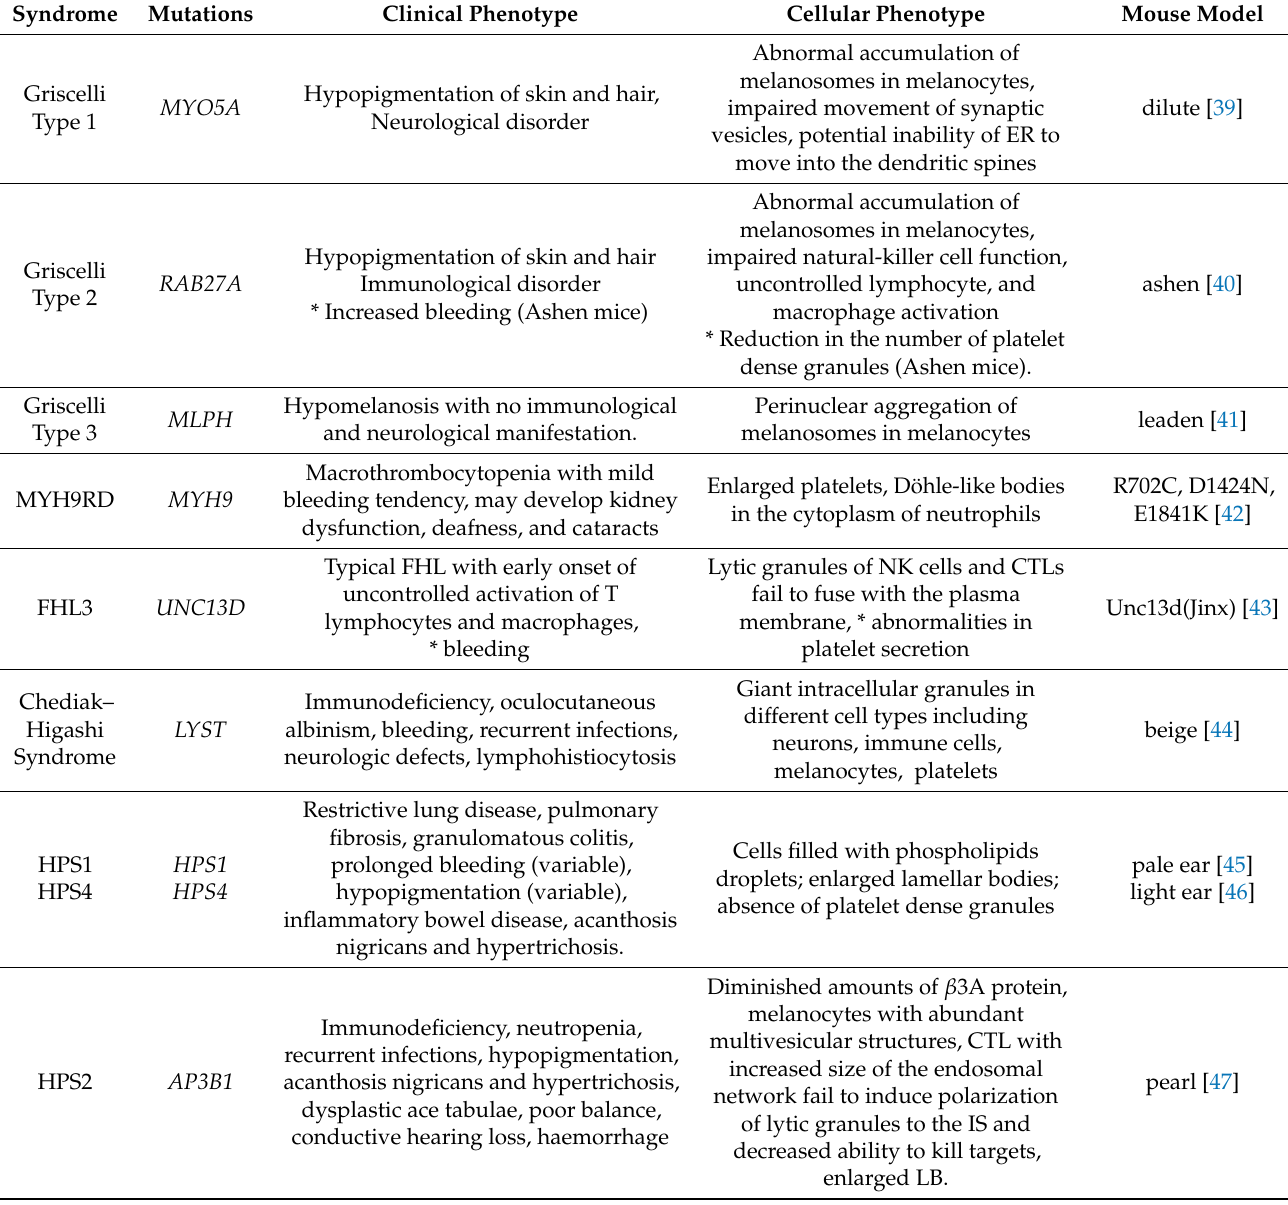
Table 1. Multisystem disorders associated with mutations in genes involved in vesicular trafficking to LROs. Mutated gene, clinical and cellular phenotype as well as the correspondent mouse model are reported. * Abnormalities observed in the mouse model. Abbreviations: MYH9 , Myosin-9; MYH9RD, MYH9-related thrombocytopenia; FHL3, Four and a half LIM domains protein 3; HPS, Hermansky–Pudlak Syndrome; ARC, Arthrogryposis, Renal dysfunction and